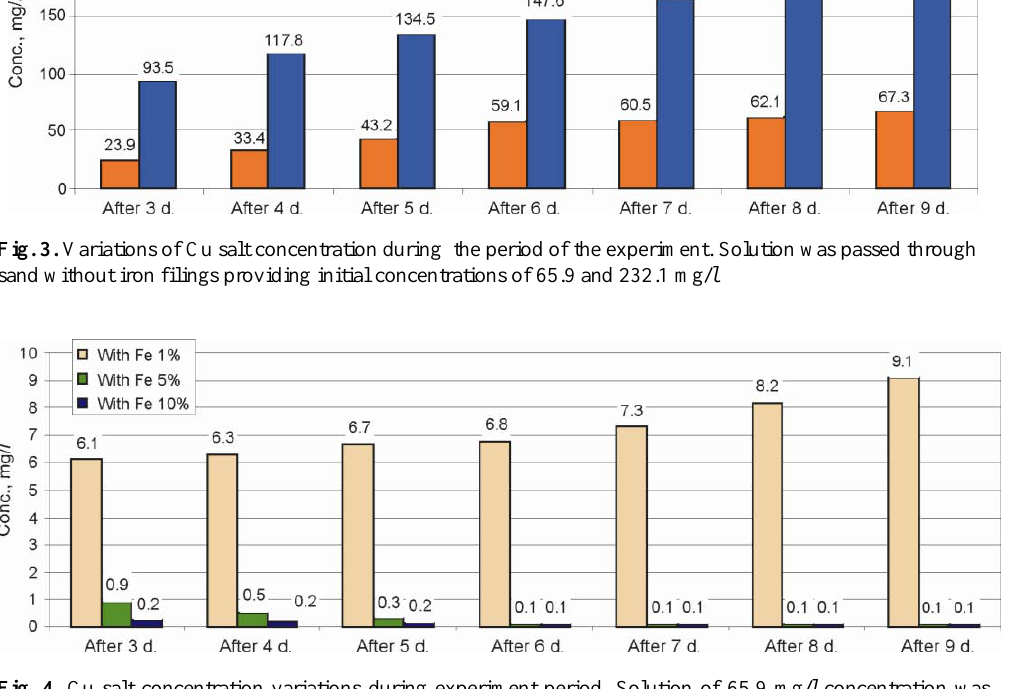
Fig. 4. Cu salt concentration variations during experiment period. Solution of 65.9 mg/ l concentration was passed through sand with different quantity of iron particles